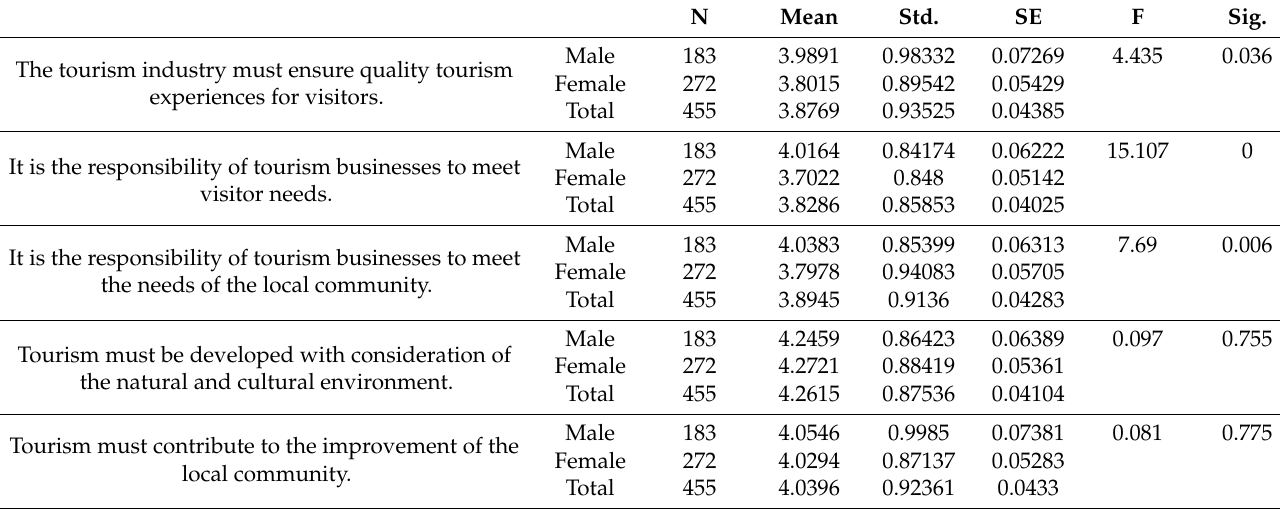
Table 5. Participants’ view of the responsibilities of the tourism industry, by